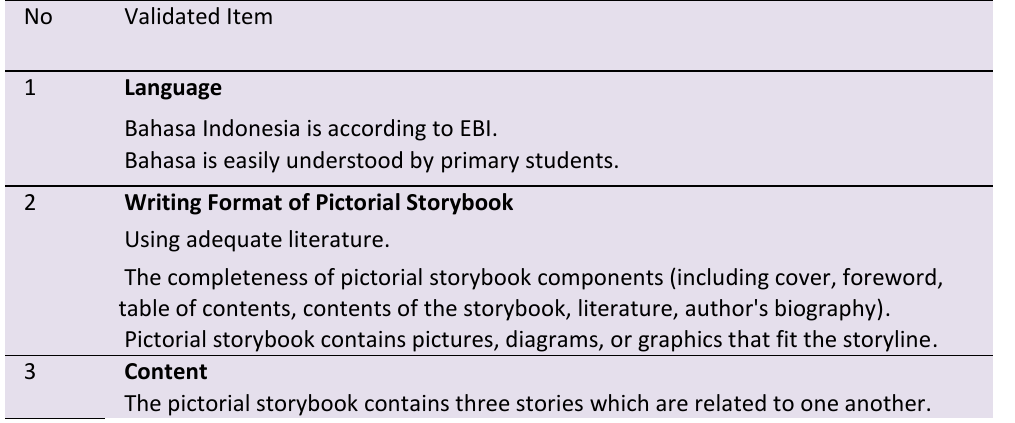
Table 4 . Outline of Validation